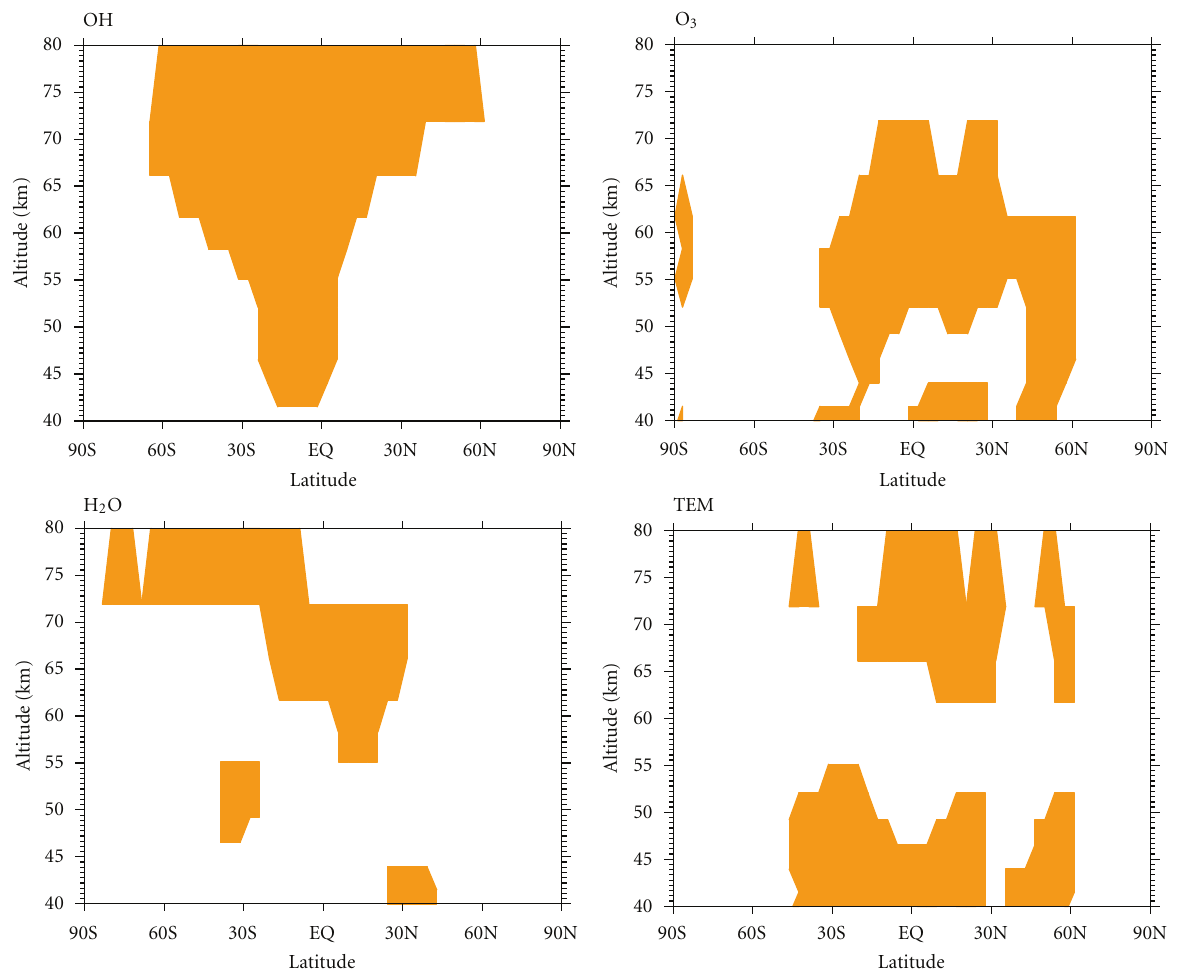
Figure 4: Areas where the nowcast and short-term forecasts of the considered quantities can be carried out with higher probability of the